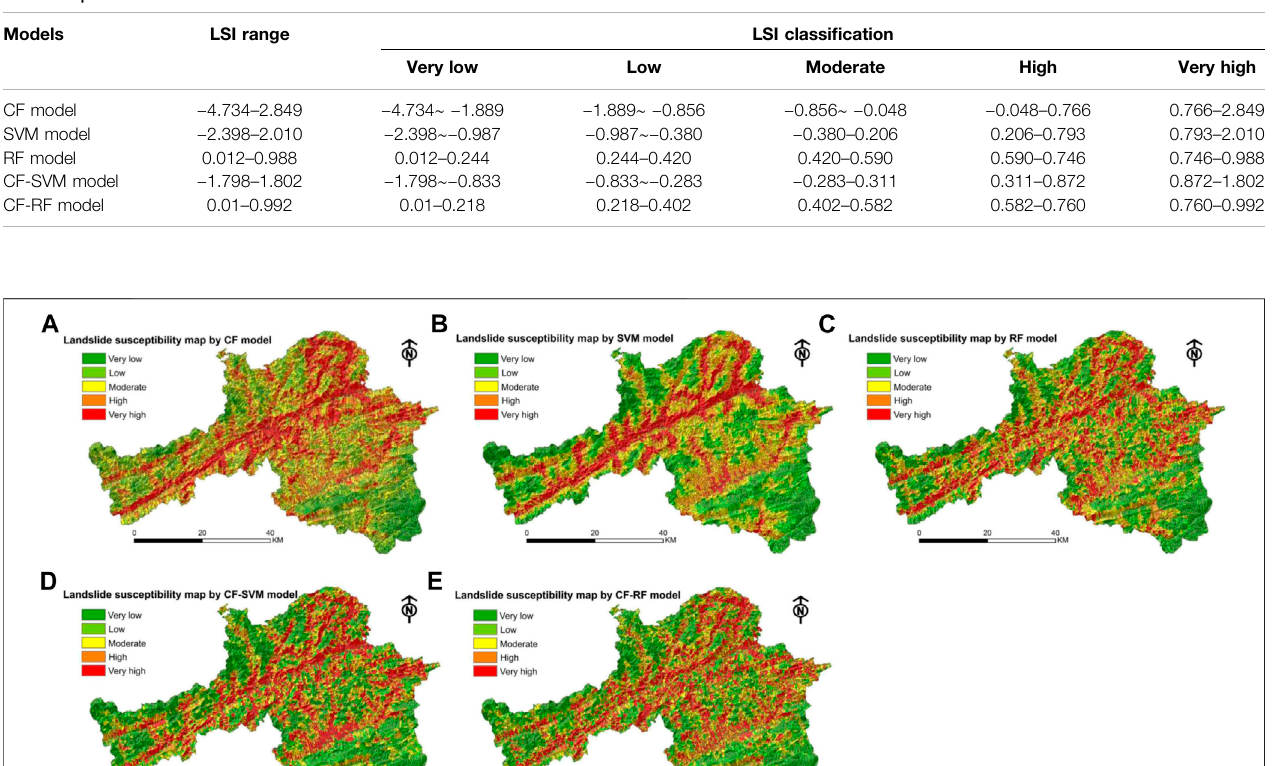
Frontiers in Earth Science |